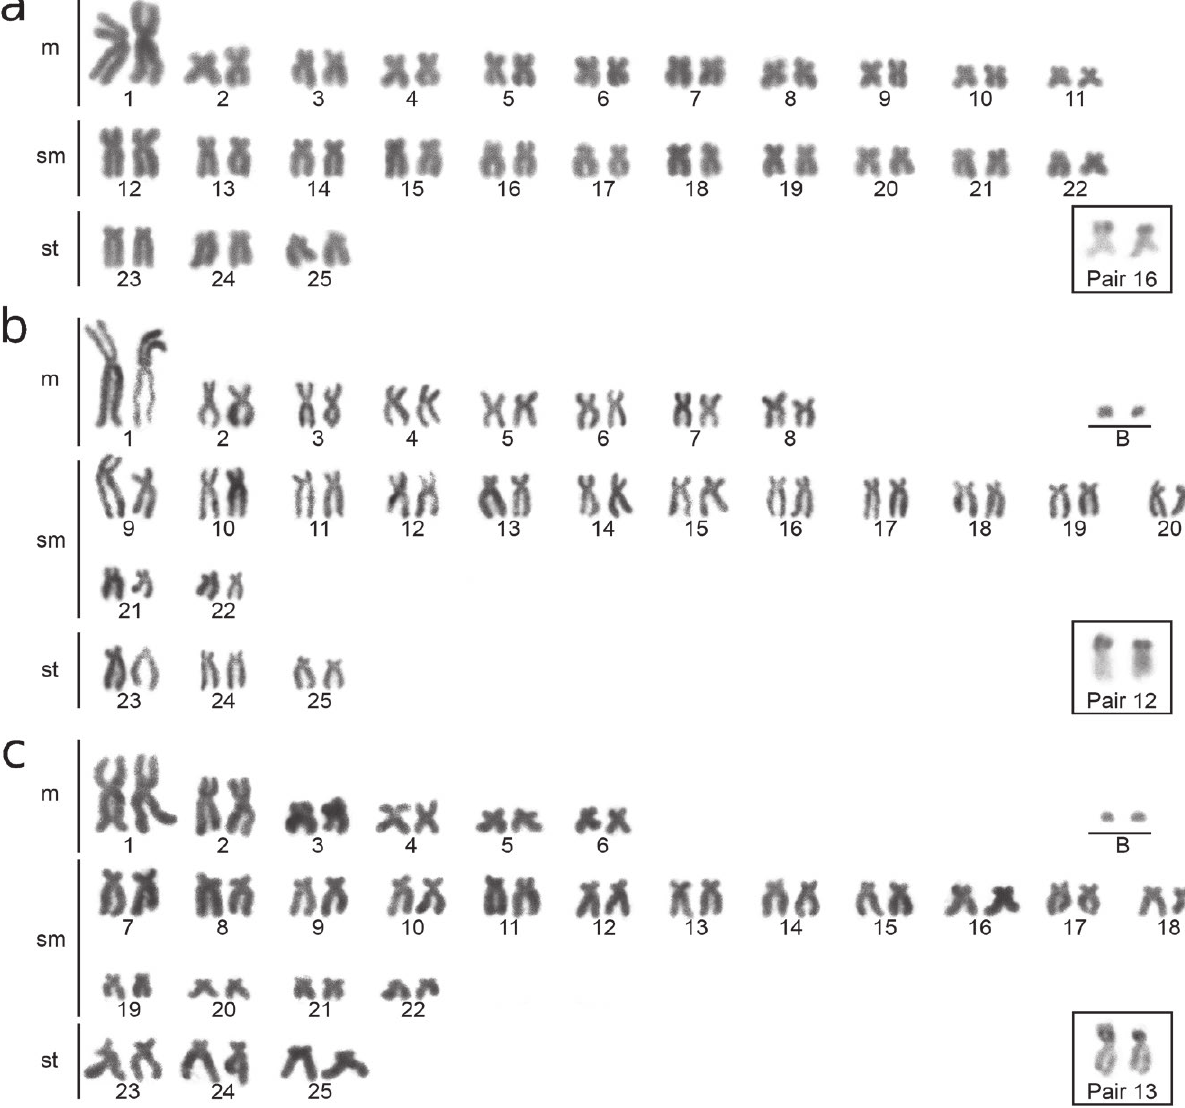
Figure 1. Giemsa stained karyotypes of Moenkhausia species: (a) M. dichroura , (b) M. intermedia and (c) M. sanctaefilomenae . NOR-bear- ing chromosomes of each species are depicted in the